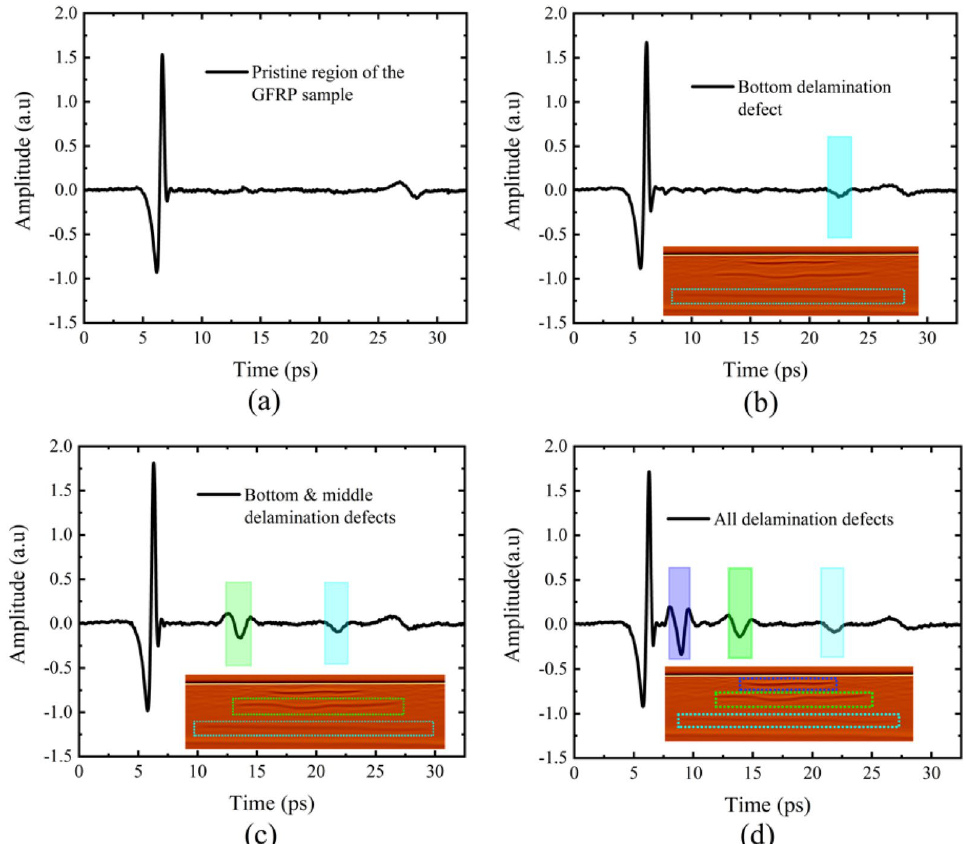
Figure 8 Time traces of the detected reflected THz signals in the time domain. The different THz signals represent a the normal/pristine region of the GFRP composite sample, b the upper delamination, c both the upper and middle delamination, and d all the 3 levels of delamination in the